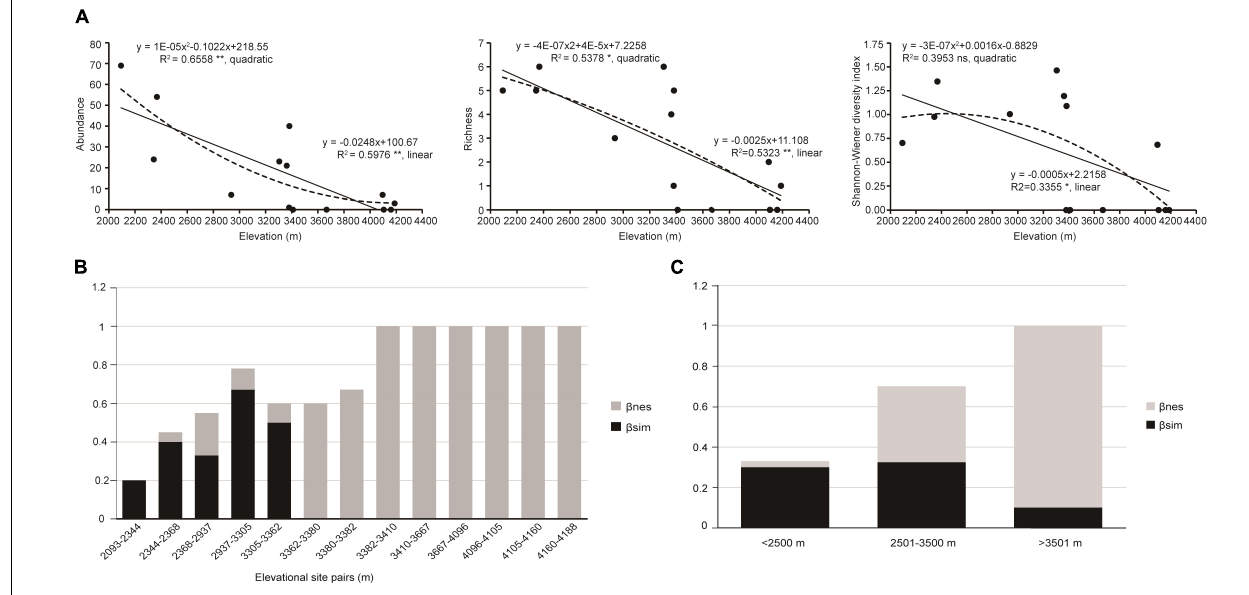
FIGURE 5 | The elevational diversity patterns of the green lacewing community from Derong County. (A) Relationships between elevation and α -diversity. The linear and quadratic regression were used to fit the elevation pattern. The goodness of fit was assessed based on the adjusted R 2 . **, *, and ns indicate significance at P ≤ 0.01, P ≤ 0.05, and non-significant, respectively. The solid lines indicate linear regression and the dashed lines indicate quadratic regression. Dissimilarity analysis (Sørensen dissimilarity index, β sor) of the green lacewings from Derong Country partitioned into Simpson dissimilarity index ( β sim) and nestedness-resultant dissimilarity ( β nes) of (B) elevational site pairs (i.e., each site and its immediately adjacent uphill site), and (C) elevational gradients.